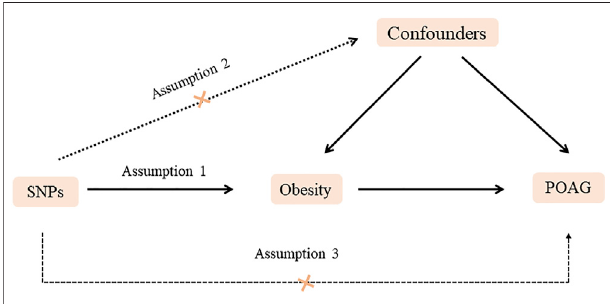
FIGURE 1 | Diagram of two-sample Mendelian randomization analysis. Assumption 1: The SNPs should be associated with POAG. Assumption 2: The selected SNPs should be independent of confounders. Assumption 3: The SNPs should affect POAG only via obesity rather than via a direct